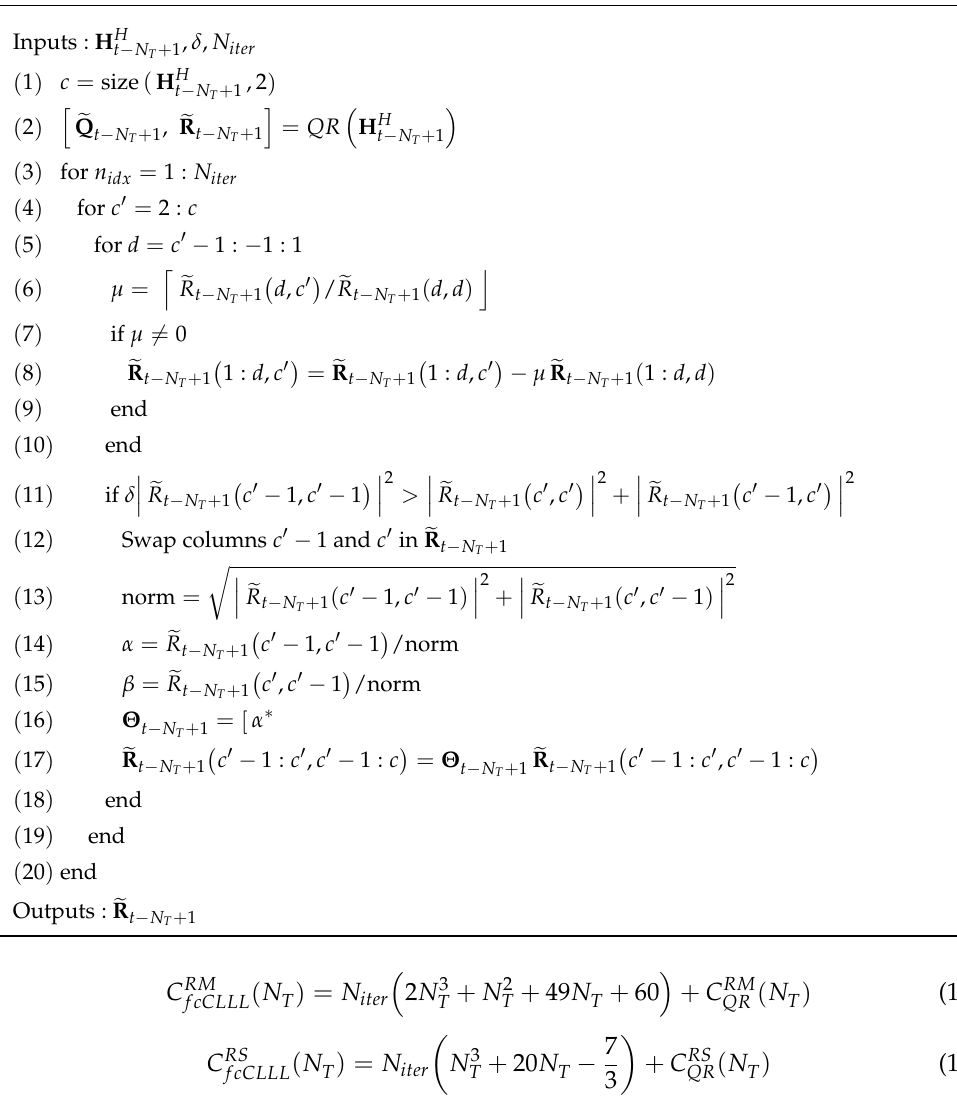
Algorithm 2: fcCLLL without Computing (cid:101) Q and (cid:101) T